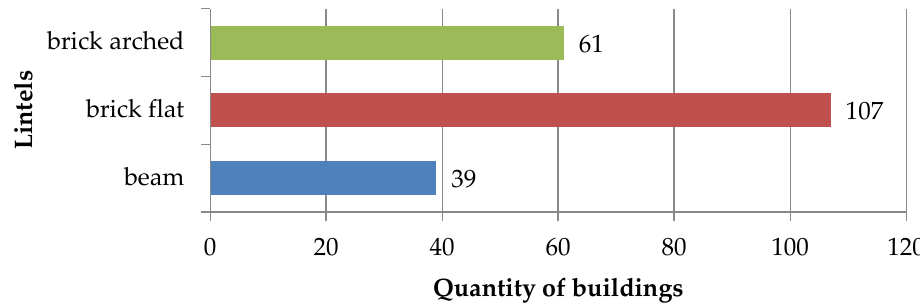
Figure 17. Distribution of data for the variable relating to door and window lintels.